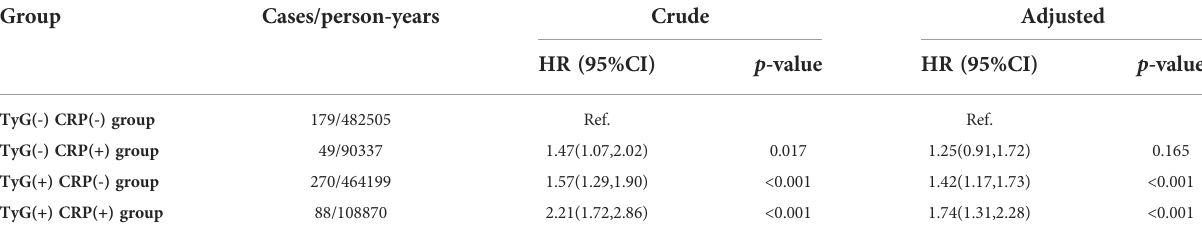
TABLE 4 Hazard ratios (HRs) for the association of TyG index and CRP levels with CRC risk.